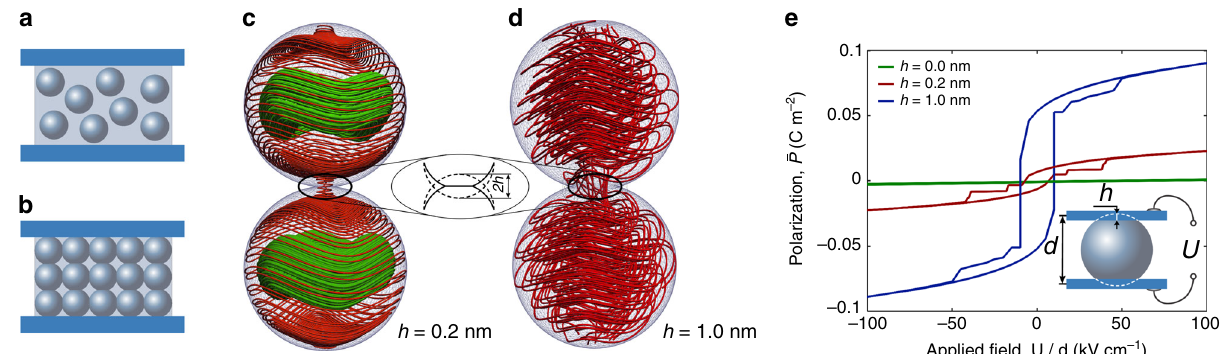
Fig. 4 Polarization in a nanoparticle composite. a Dilute composite of isolated nanoparticles in a capacitor. b Sintered composite of contacting nanoparticles. c Field lines fl ow between moderately densi fi ed nanoparticles of R = 25 nm, contacted along the [111] direction. The densi fi cation degree is characterized by the thickness of the connecting neck 2 h = 0.4 nm, see inset. The delocalized helical lines fl owing between the particles are embraced by the localized lines forming the toroidal Hop fi on states. d In a composite of strongly densi fi ed nanoparticles with 2 h = 2 nm, all the fi eld lines form delocalized helices fl owing across the entire composite. e The polarization hysteresis loops for a single nanoparticle in the sintered composite as a function of the applied fi eld, U / d for different densi fi cation degrees h . The inset sketches a model particle with cut skullcaps of the height h con fi ned between the electrodes which mimics the behavior of